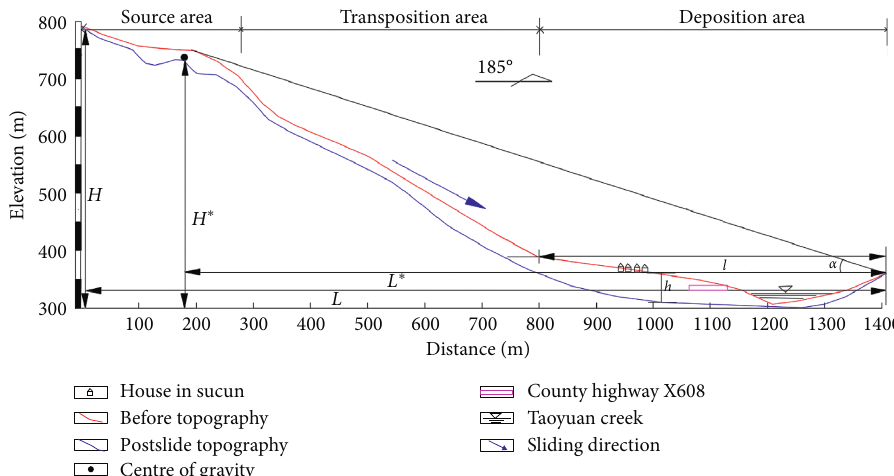
Figure 12: Parameters of the Sucun landslide (modified from Adushkin et al.